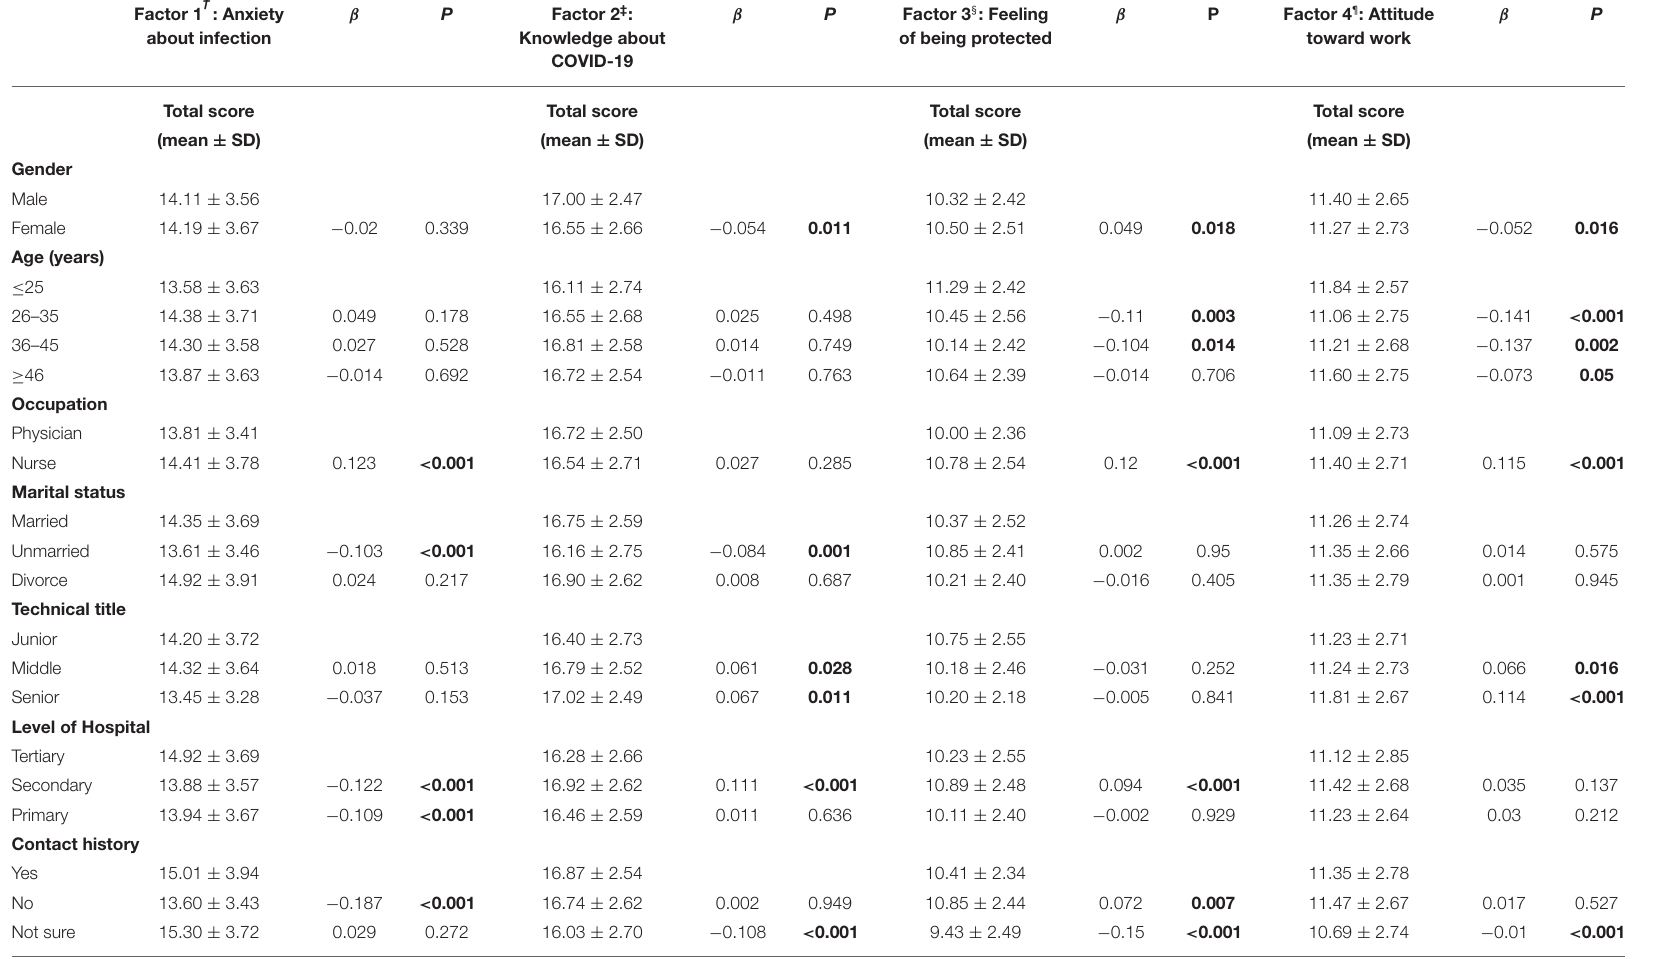
TABLE 3 | The association of personal characteristics with each score of the four